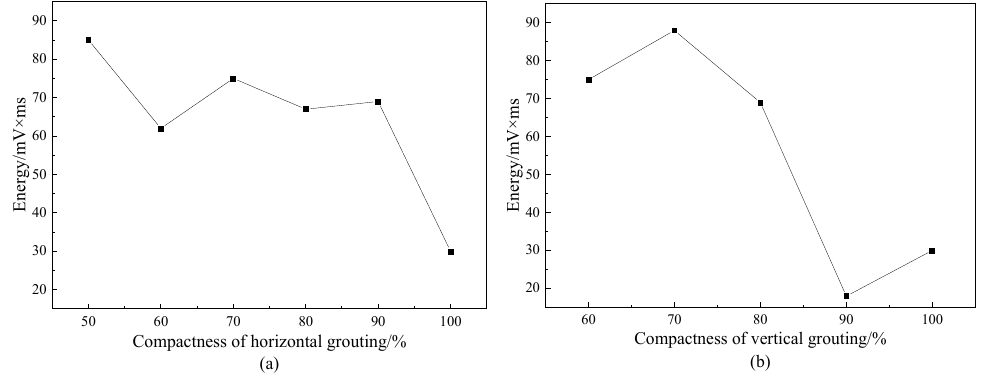
Figure 7. Acoustic emission signal energy with different grout saturation.